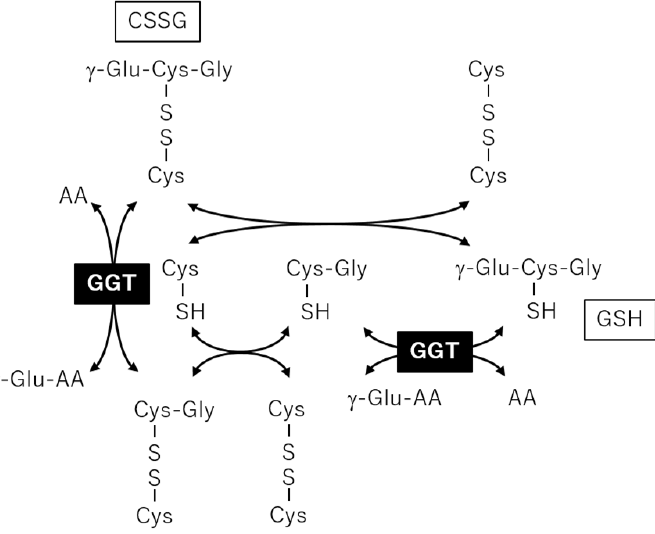
Figure 7. Metabolic reactions among glutathione and cysteine glutathione disulfide (CSSG) to provide a basis for correlation between gamma-glutamyl transpeptidase ( γ -GT) and CSSG.